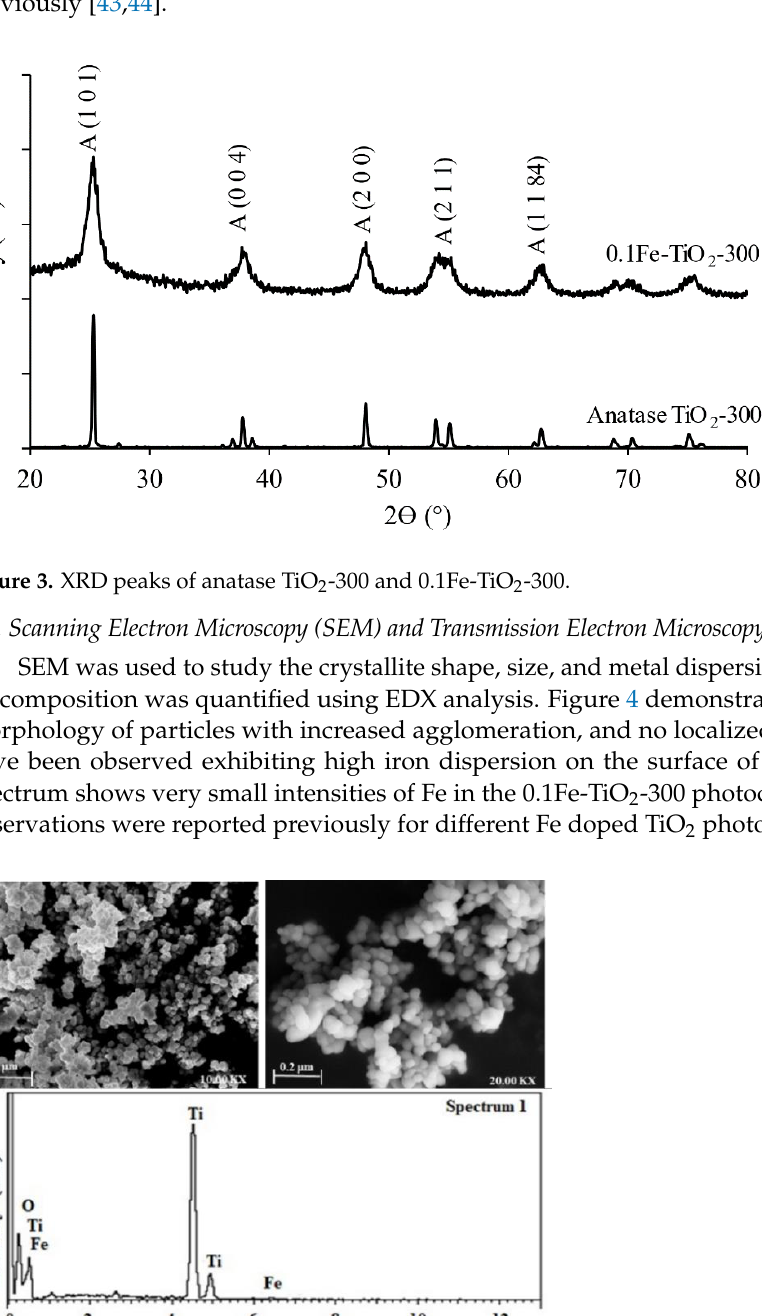
Figure 5. ( a )TEM micrographs and ( b ) size distribution histogram of 0.1Fe-TiO 2 -300.